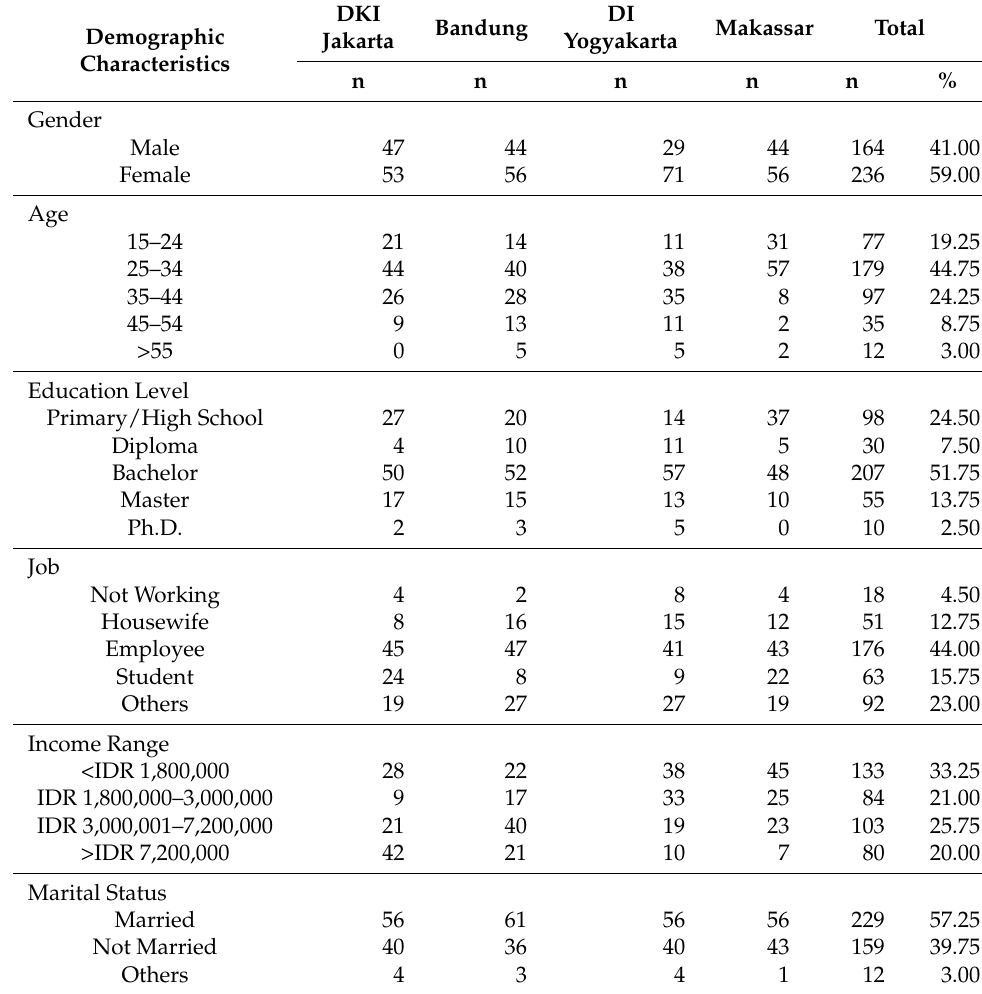
Table 2. Demographic Characteristics of Respondents’